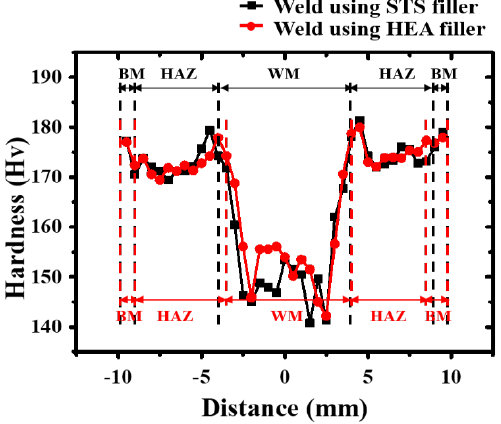
Figure 6. Hardness distribution behaviour of the welds using HEA and STS 308L fillers.